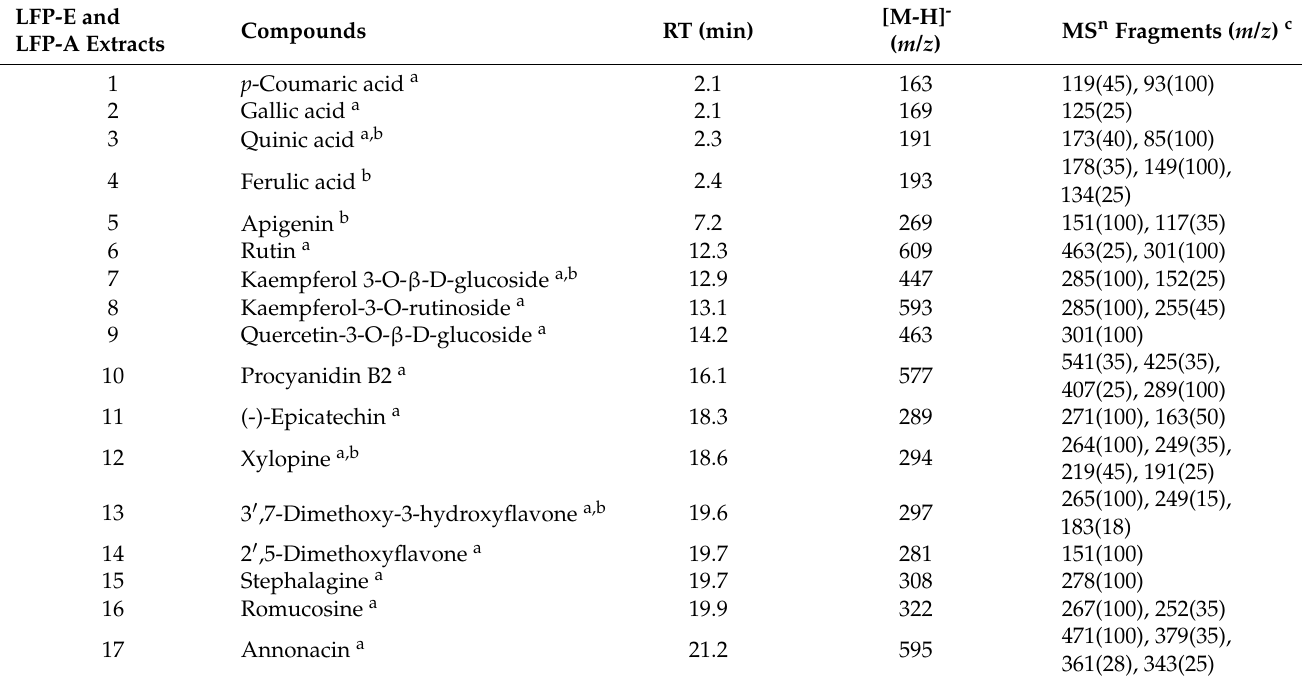
Table 1. Mass spectral characteristics of secondary compounds detected by HPLC-ESI-IT-MS in the A. crassiflora pulp fruit extracts at negative ionization mode *.